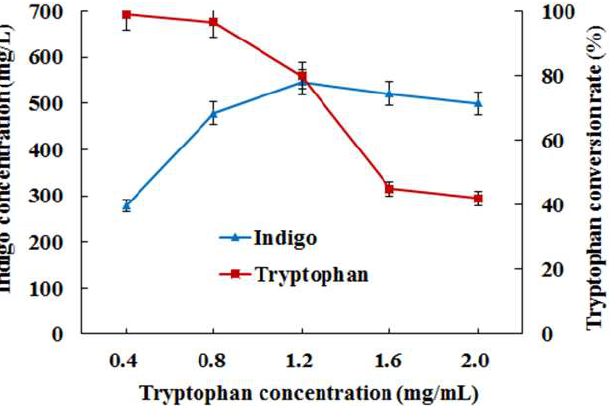
Figure 9. Indigo biosynthesis from different concentrations of tryptophan in E. coli ABP fermenta- tion.